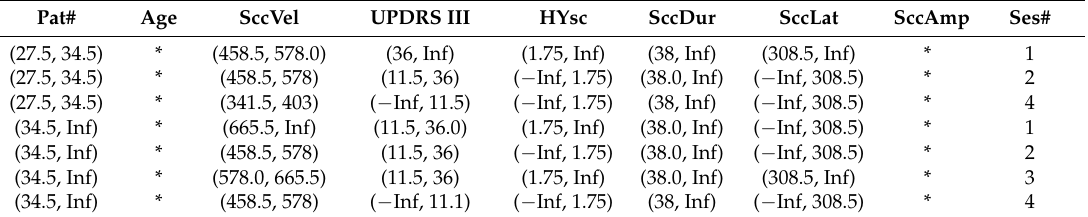
Table 7. Part of the decision discretized-table with eye movement measurements.